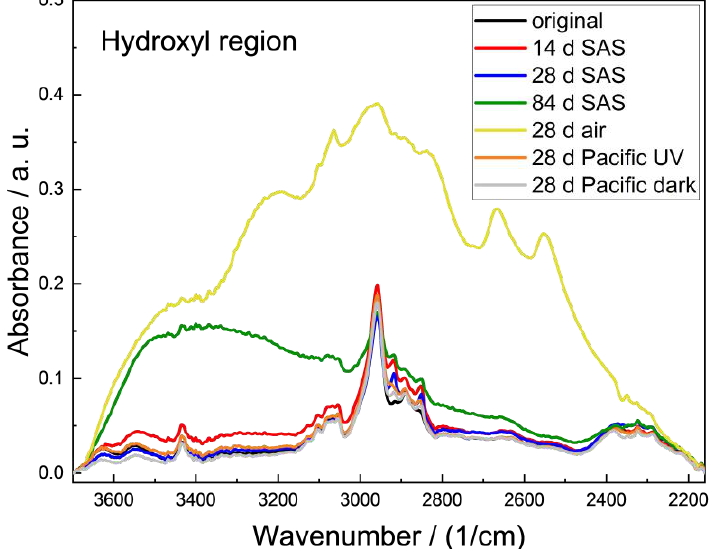
Figure 6. Comparison of the hydroxyl regions in the FTIR spectra of differently weathered PET sheets (colored lines) with the original sample (black line). The air-weathered sample differs from the other samples by the increase in absorption in the whole region (yellow).